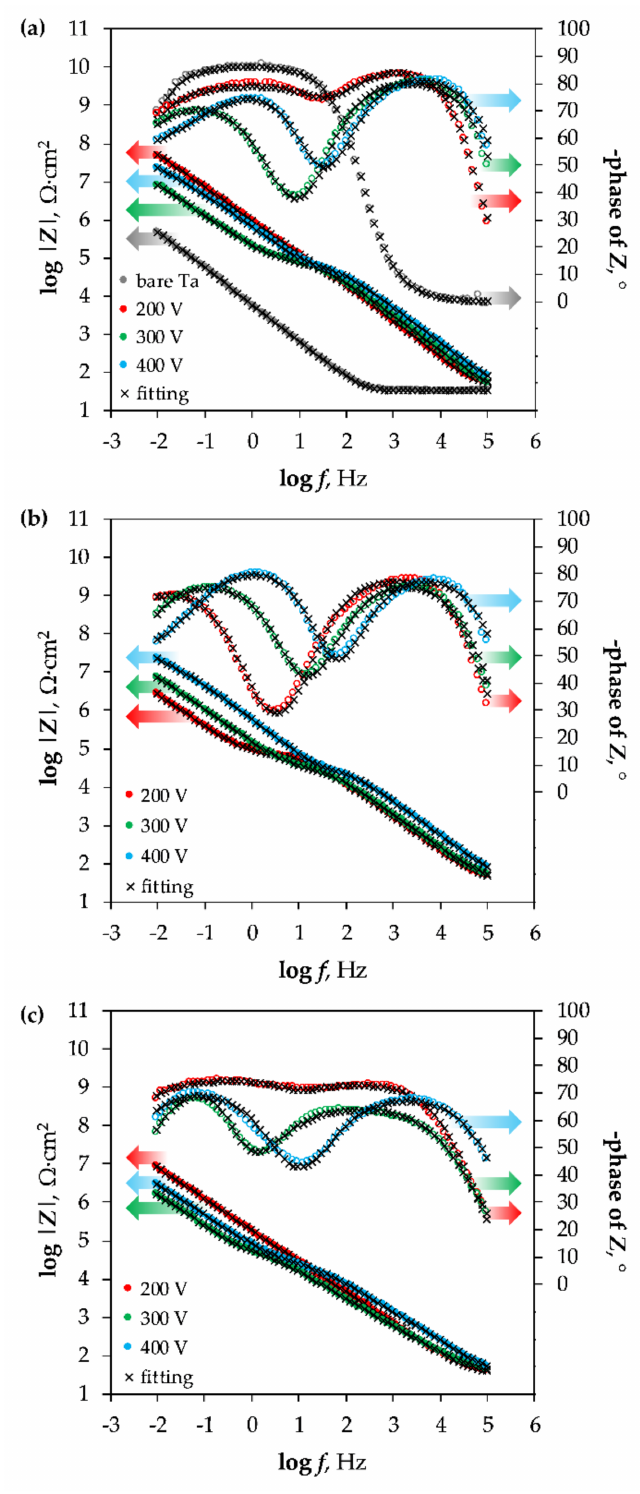
Figure 5. Bode plots of impedance spectra recorded for the Ta specimens before (bare Ta) and after the PEO in the solutions: Ca1P2 ( a ), Ca5P3 ( b ) and (CaMg)5P3 ( c ); arrows indicate which part of the plots correspond to the impedance magnitude points ( | Z | ), and the phase of Z